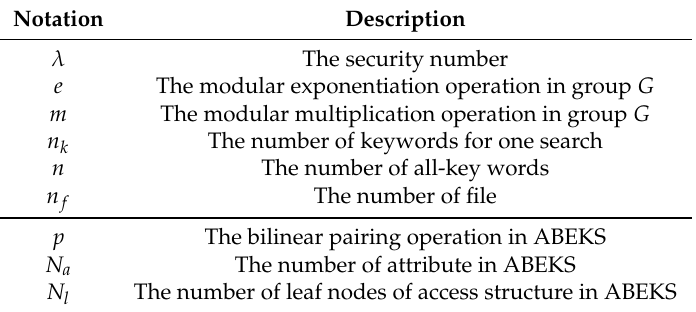
Table 1. Notation used in performance